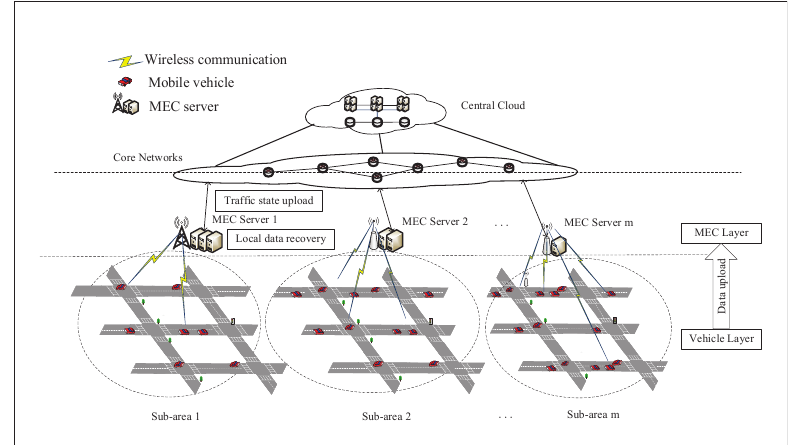
Figure 1. Service Architecture of Traffic monitoring in MEC-based Vehicular Networks.